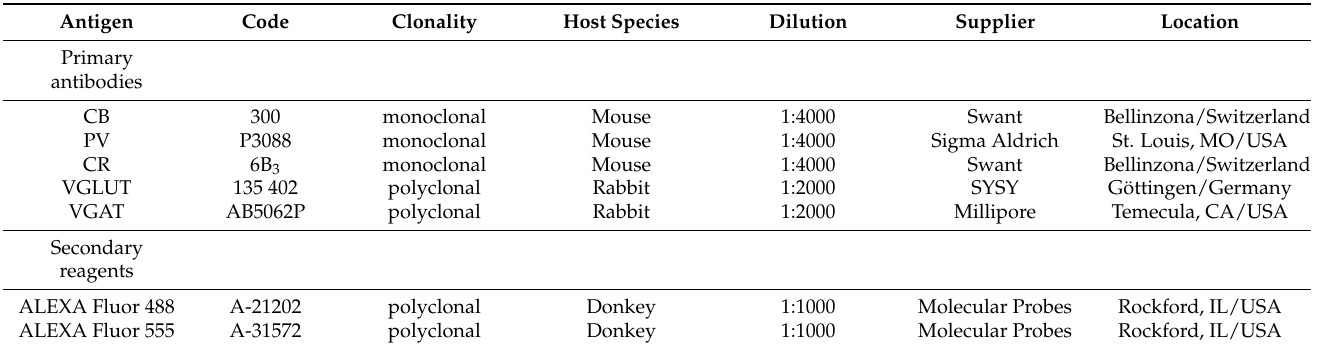
Table 2. Specification of